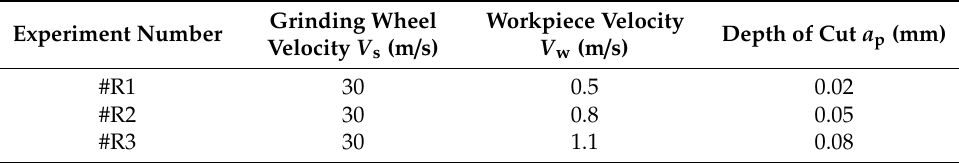
Table 2. Grinding parameters of the rail specimens.